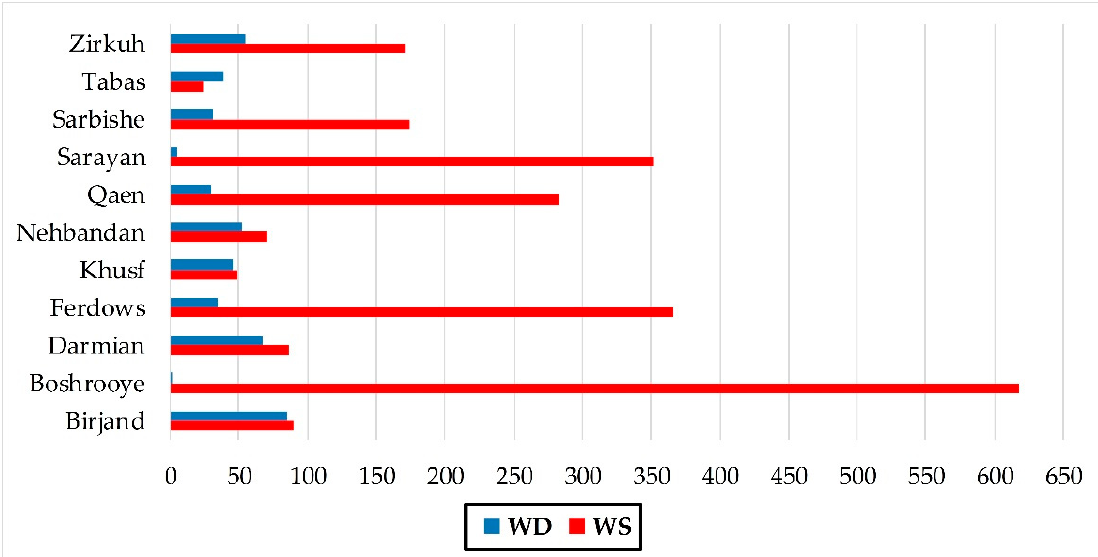
Figure 7. Water dependency against water scarcity in each county.